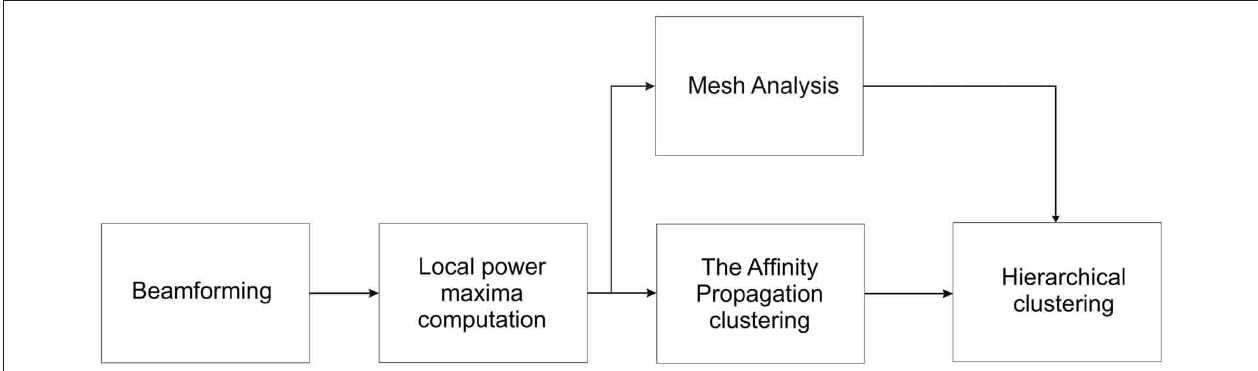
FIGURE 3 | The flow chart of the proposed method. The beamformer computes the average power at each voxel. Local maxima of average power is then computed using a frequency-dependent power threshold, and the peaks are extracted. The Affinity Propagation algorithm is used on the resulted peaks to cluster them. A cluster tree is then built by